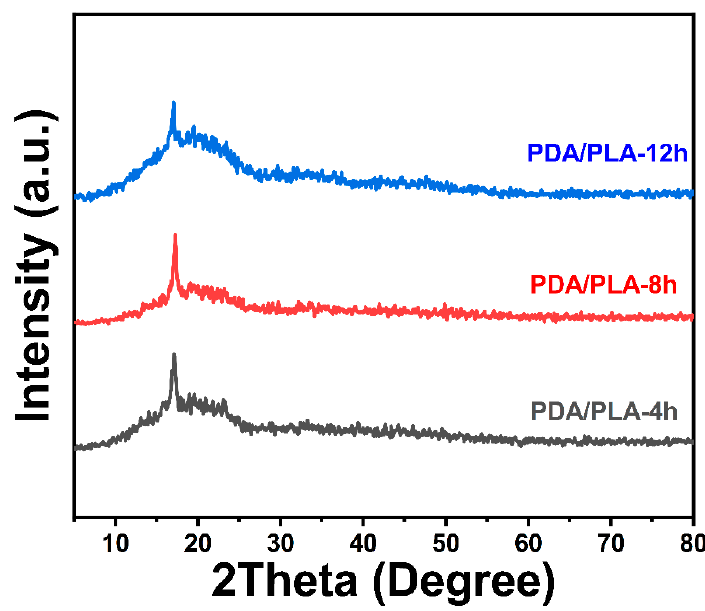
Figure 4. XRD pattern of PDA/PLA scaffolds with different immersion times in poly(dopamine).